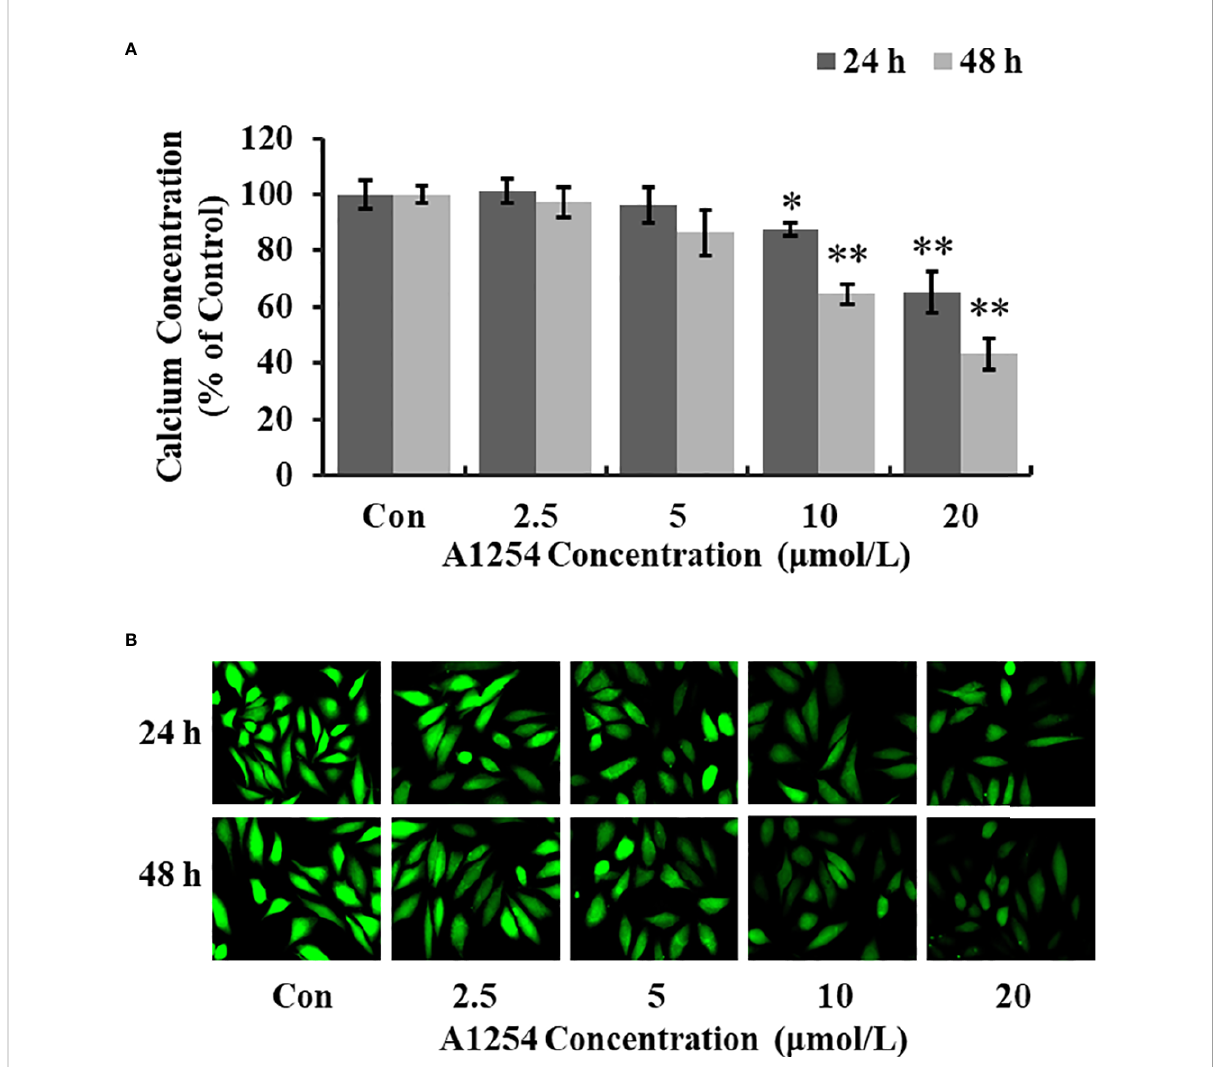
FIGURE 3 The calcium concentration in MC3T3-E1 cells affected by A1254. MC3T3-E1 were exposed to various doses of A1254 for 24 and 48h. The calcium concentration was assessed with fl uorescence microscopy using a Fluo 4-AM probe. Fluorescent intensity was measured and recorded at 528 nm emission and 488 nm excitation; and data were analyzed using the Ipwin32 software. (A) Relative intracellular calcium levels compared to control. (B) Representative fl uorescence images. Each experiment was repeated three times. *p<0.05, **p<0.01 compared to the